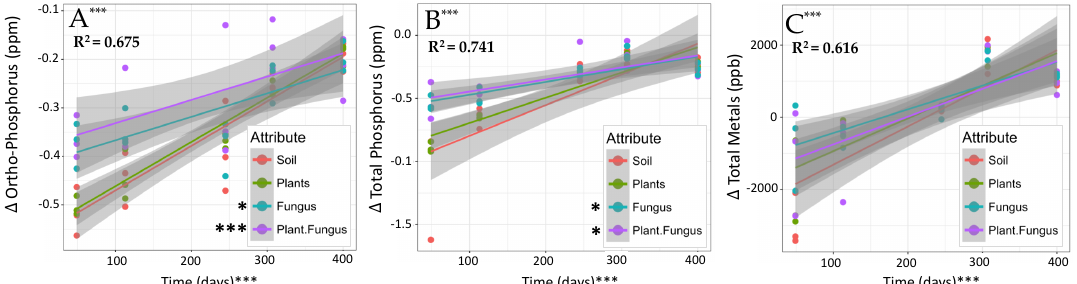
Figure 5. Multiple linear regression models with 95% confidence intervals for ortho-phosphorus ( A ), total phosphorus ( B ) and total metals ( C ) as functions of time and biological amendment factor. In all subfigures the * symbol indicates statistical significance: * p < 0.05, ** p < 0.01, *** p < 0.001. The asterisk next to each panel letter indicates the significance of the regression model. The marginal significance of the individual model variables are indicated for time and biological